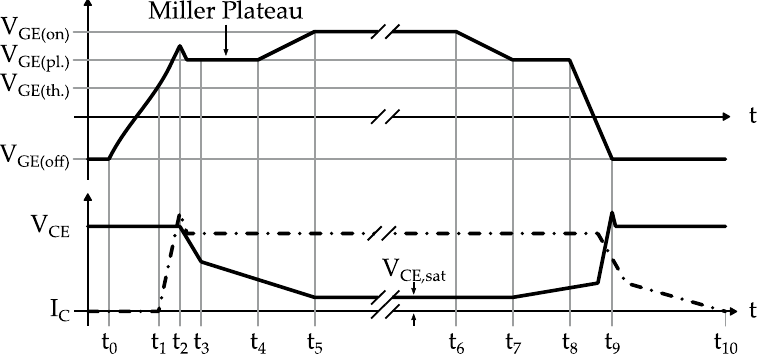
Figure 3. Idealized voltage ( V GE , V CE , continuous lines) and current ( I C , dashed line) switching characteristics during turn-on and turn-off operation of an IGBT [38].